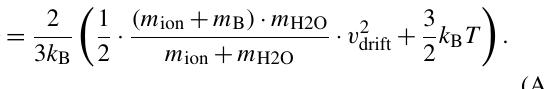
Figure A1. Measured (blue points) and expected sensitivities for the PTR3 plotted versus the respective proton affinities (PA). Orange crosses represent expected sensitivities taking into account the back reaction with water vapour and assuming ionization of the respec- tive species with all water clusters H 3 O + · (H 2 O) n ; n = 0–6. The black crosses are adjusted to react only with the lowest water clus- ters n = 0– k with k = 2 for methanol, acetonitrile, and α -pinene; k = 1 for isoprene. The error bars represent the combined uncertain- ties of the expected values resulting from uncertainties of the water vapour partial pressure (1 . 2 ± 0 . 6mbar), temperature (30 ± 5 ◦ C), and reduced electric field strength (60 ± 5Td) in the reaction cham- ber. The proton affinities of D4 and D5 siloxanes are unknown, shown for reference only and assumed to be > 200kcalmol − 1 .